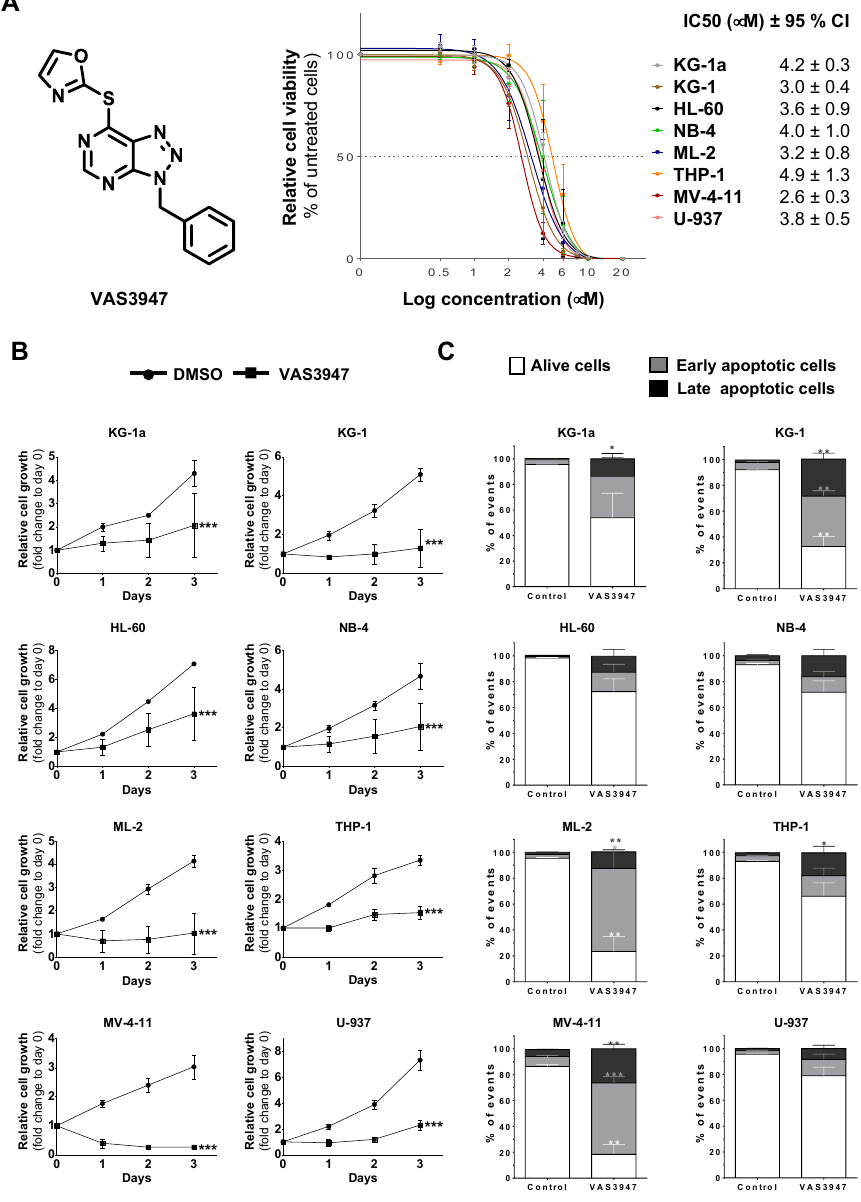
Figure 1. Effect of 4 µM VAS3947 on cell growth. ( A ) Dose-response curves of VAS3947 for eight acute myeloid leukemia (AML) cell lines, as indicated, and the corresponding IC50 (in µM) ± 95% confidence interval (CI). ( B ) Effect of VAS3947 on the growth of eight AML cell lines. Cell proliferation